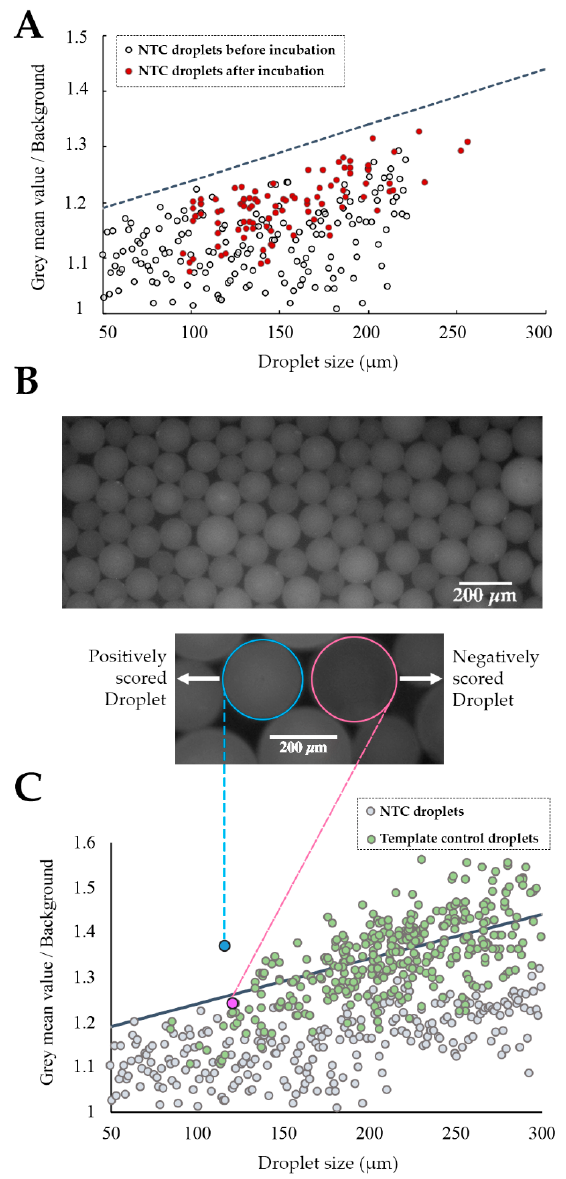
Figure 3. Chip-based ddLAMP. ( A ) Threshold definition; fluorescence measurements of droplets without a template before and after end-point reaction. ( ￮ ) Represents the NTC droplets before incubation at 65 °C and ( ● ) Represents the NTC droplets after incubation at 65 °C. The threshold ( --- ) equation is y = 0.001x + 1.14. ( B , top ) Fluorescence image of on-chip ddLAMP droplets from a template sample after end-point amplification. ( Bottom ) Representative fluorescence image of a ( ￮ ) negative droplet vs. a ( ￮ ) positive droplet. Scale bar of 200 µm in length; ( C ) Assessment of the threshold differentiation capability. Negative/positive droplet score. Only droplets with fluorescence above the threshold were scored as positive. ( ● ) Represents droplets from the NTC sample after end-point reaction. ( ● ) Represents droplets from the template sample after end-point LAMP reaction. ( ● ) Represents a negatively scored droplet from the template sample (fluorescence image shown in Figure 3B and ( ● ) represents a positively scored from the template sample (fluorescence image shown in Figure 3B).